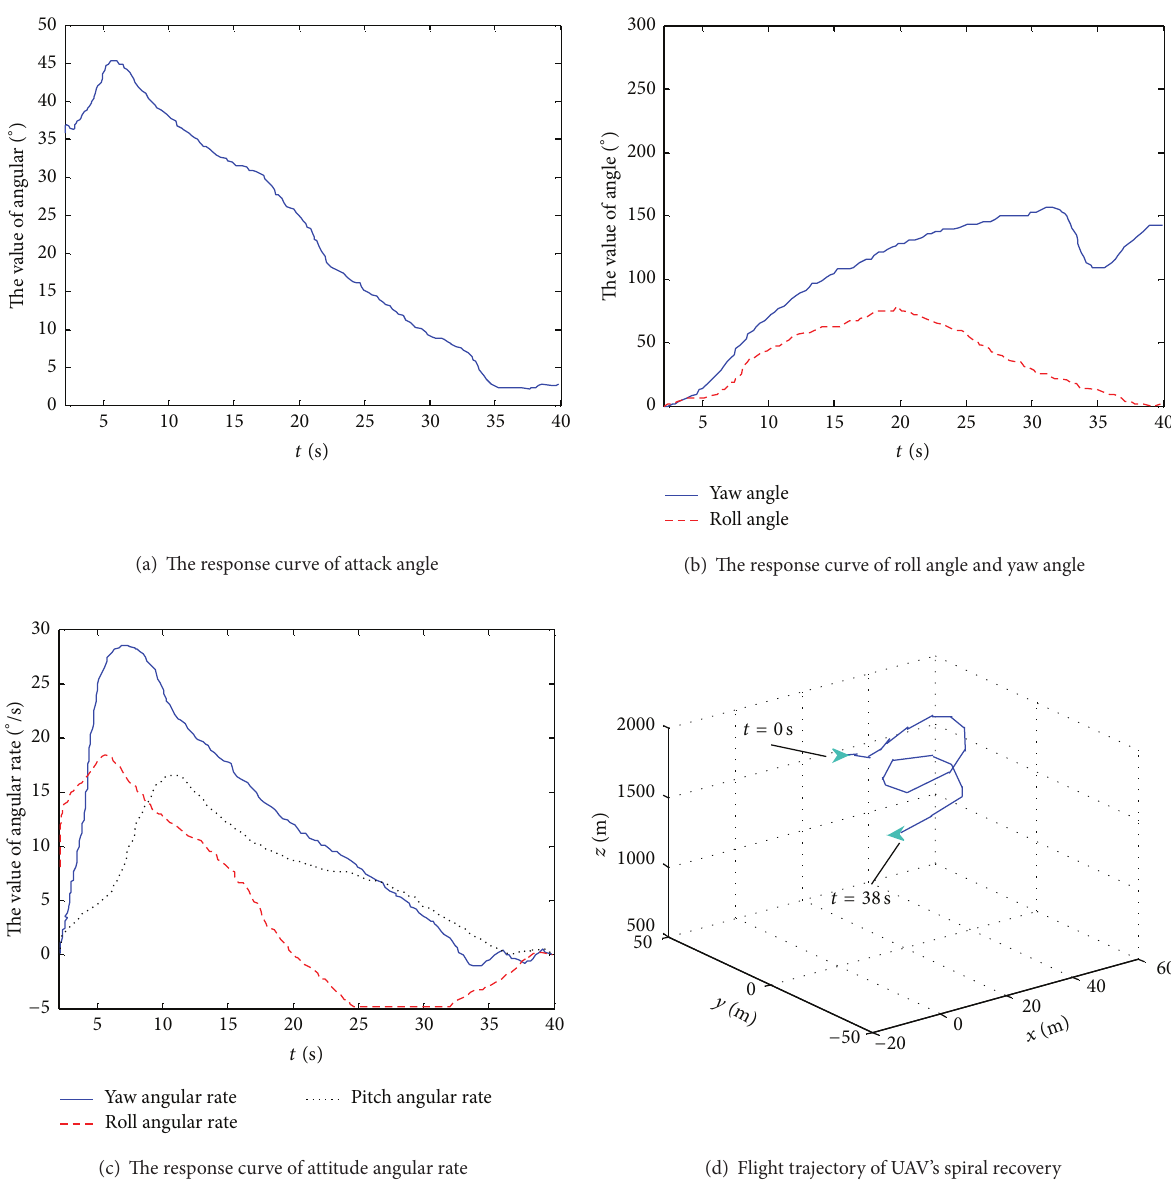
Figure 7: The dynamic process of UAV’s spiral